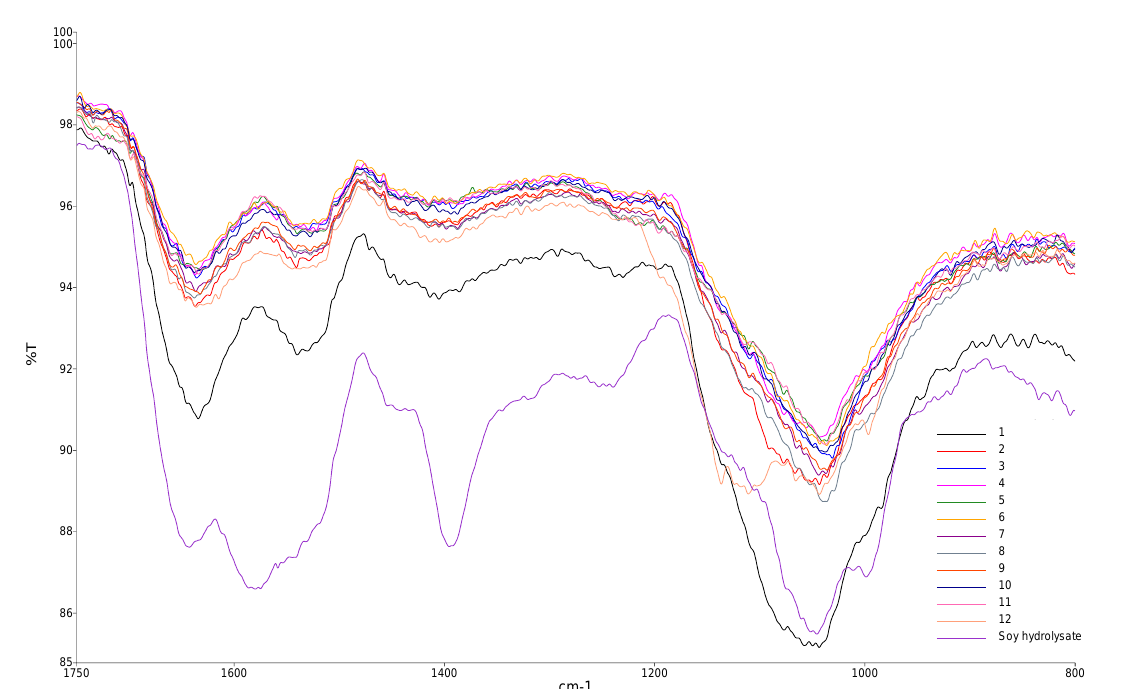
Figure 2. FTIR spectral overlays of copper proteinates formed from a variety of enzymatic hydrolysis procedures. 1–12 refer to the individual hydrolysates outlined in Table 1.